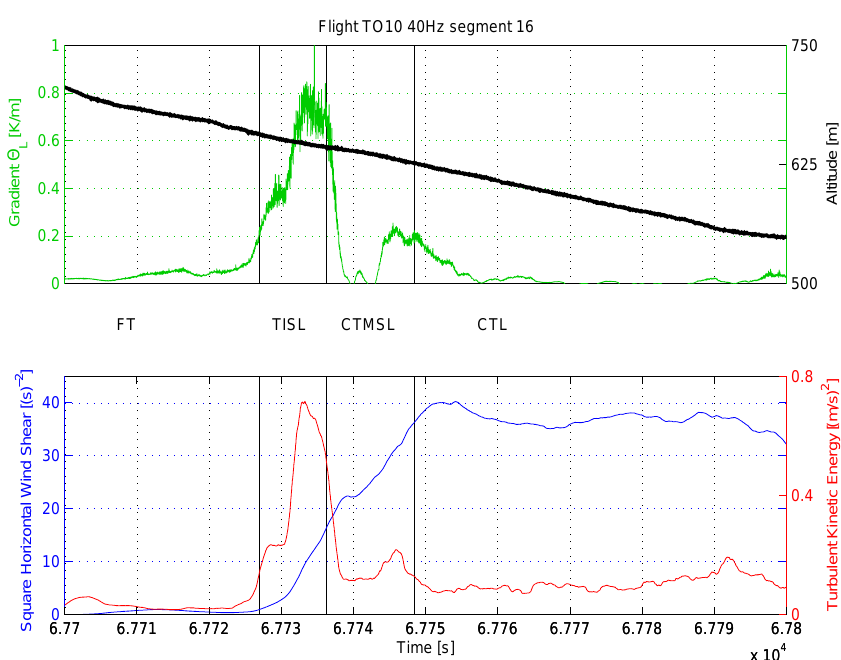
Fig. 12. Gradient of the liquid water potential temperature, horizontal wind, and turbulent kinetic energy for the same descending segment of flight TO10 shown in Fig. 3. Three black vertical lines mark borders between the free troposphere, the inversion, the cloud mixing layer and the cloud top.